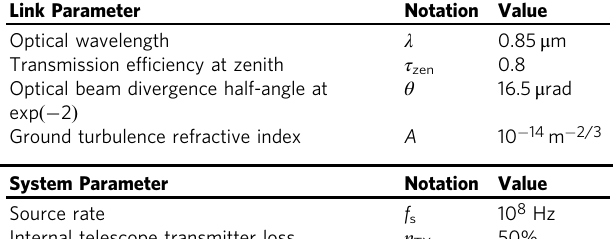
Fig. 5 Illustration of CubeSOTA terminal onboard a 6U-CubeSat. The size of the 6U-CubeSat platform is 22.63 cm width × 10 cm depth × 34.05 cm height.